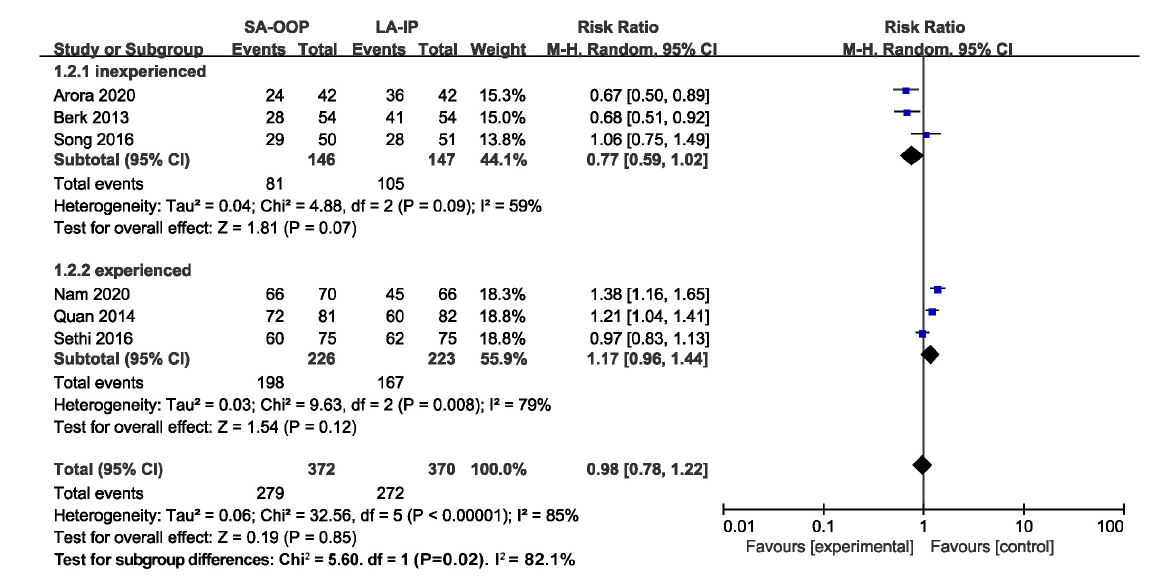
FIGURE3 Forest plot depicting first-attempt success (subgroup analysis of special short axis technique).